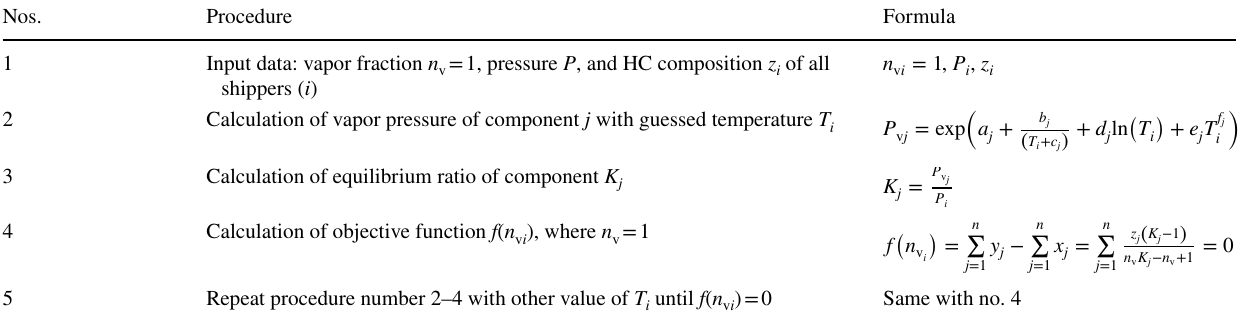
i = shipper ; j = component Table 7 Calculation procedure of vapor fraction ( n v )